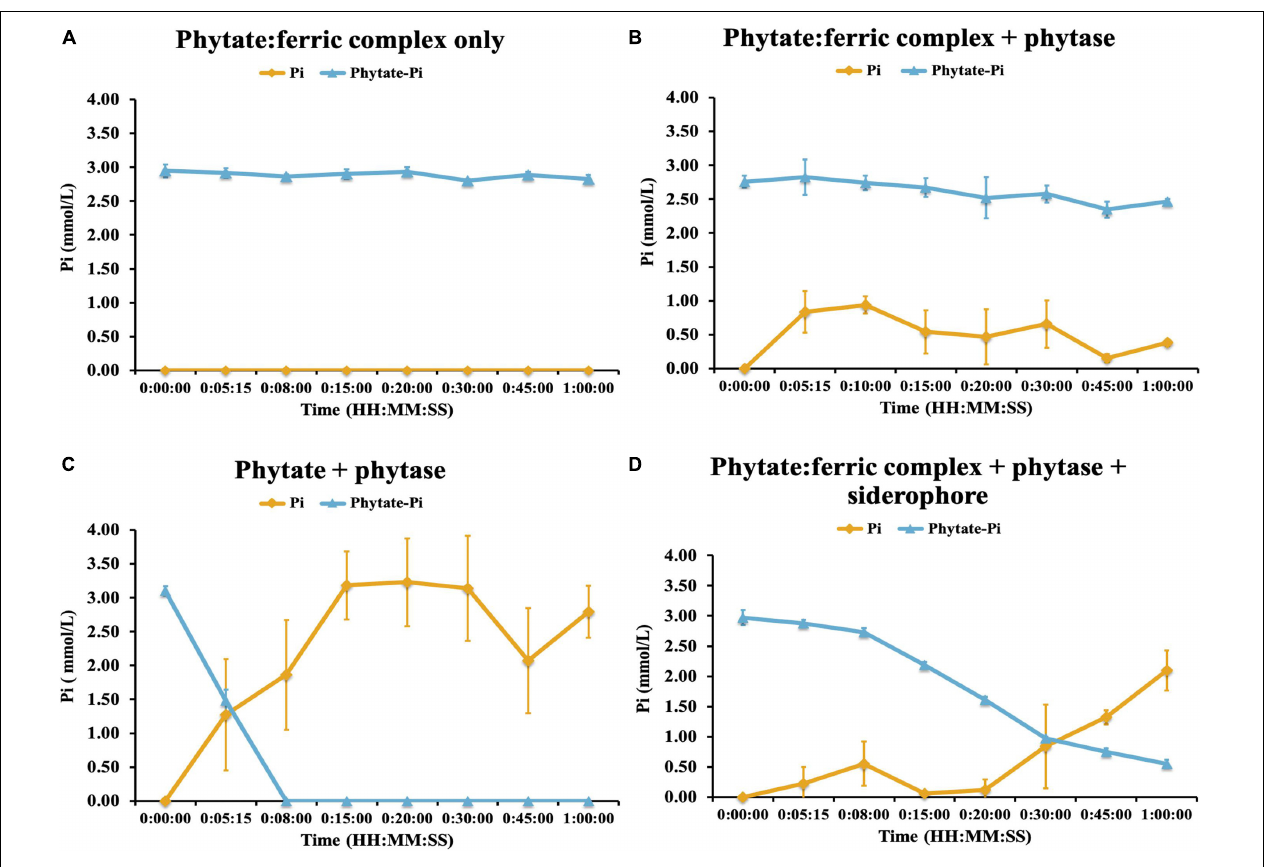
FIGURE 7 | Phytase hydrolysis kinetics on ferric-complexed phytate: (A) ferric-phytate complex only (B) ferric-phytate complex incubated with phytase (C) phytate incubated with phytase (D) ferric-phytate complex incubated with phytase and a siderophore (ferrichrome). Concentration of free PO 4 (yellow line) and PO 4 of phytate (blue line) were measured by ion chromatography over 1 h. Each treatment had three replicates. Standard deviations are indicated by the error